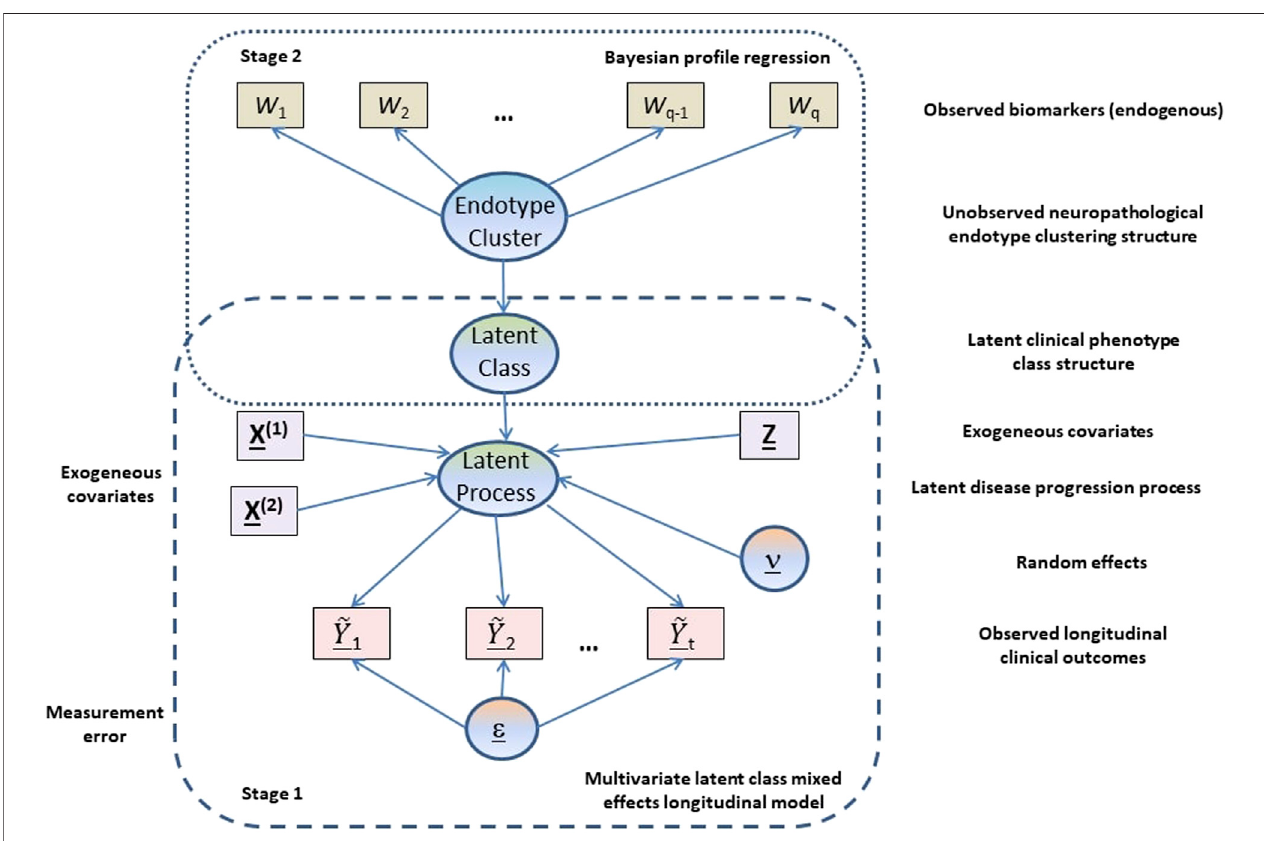
FIGURE 1 | Graphical representation of the proposed two-stage approach.